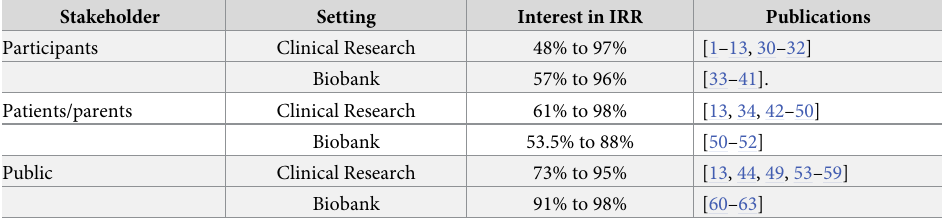
Table 4. Summaries of articles that address stakeholder interest in receiving study-specific